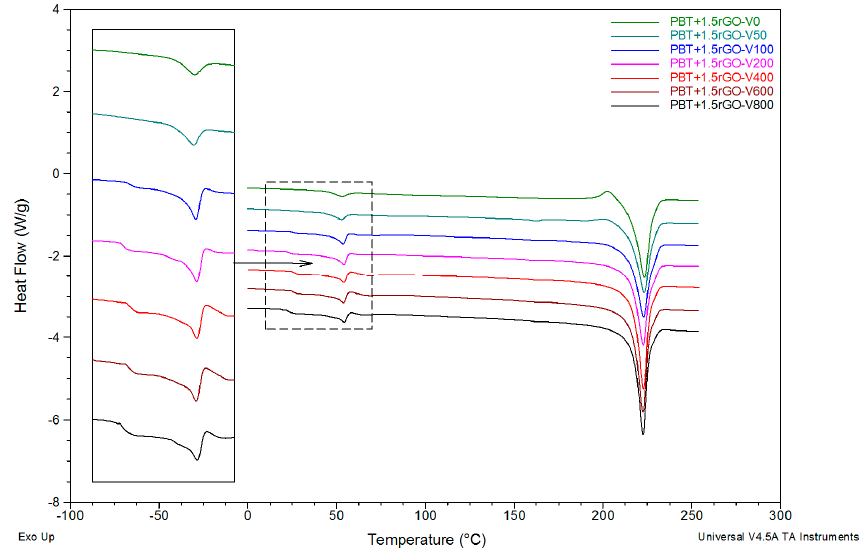
Figure 6. Illustration of the phase transitions that occur under the influence of heating: recrystallization within the existing PBT crystalline phase for fibers formed at take-up velocities from 0 to 50 m/min; phase transition of the smectic phase to the α -form for fibers formed at a take-up velocity above 400 m/min.